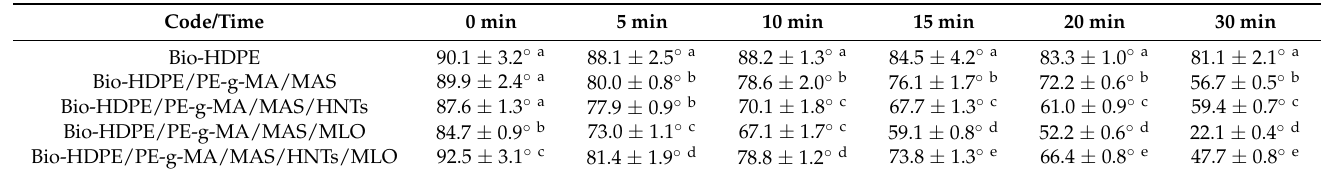
Table 7. Contact angle ( θ w ) of different Bio-HDPE/PE-g-MA/MAS blends with different compatibilizers at several times of exposure to water: 0, 5, 10, 15, 20 and 30 min.